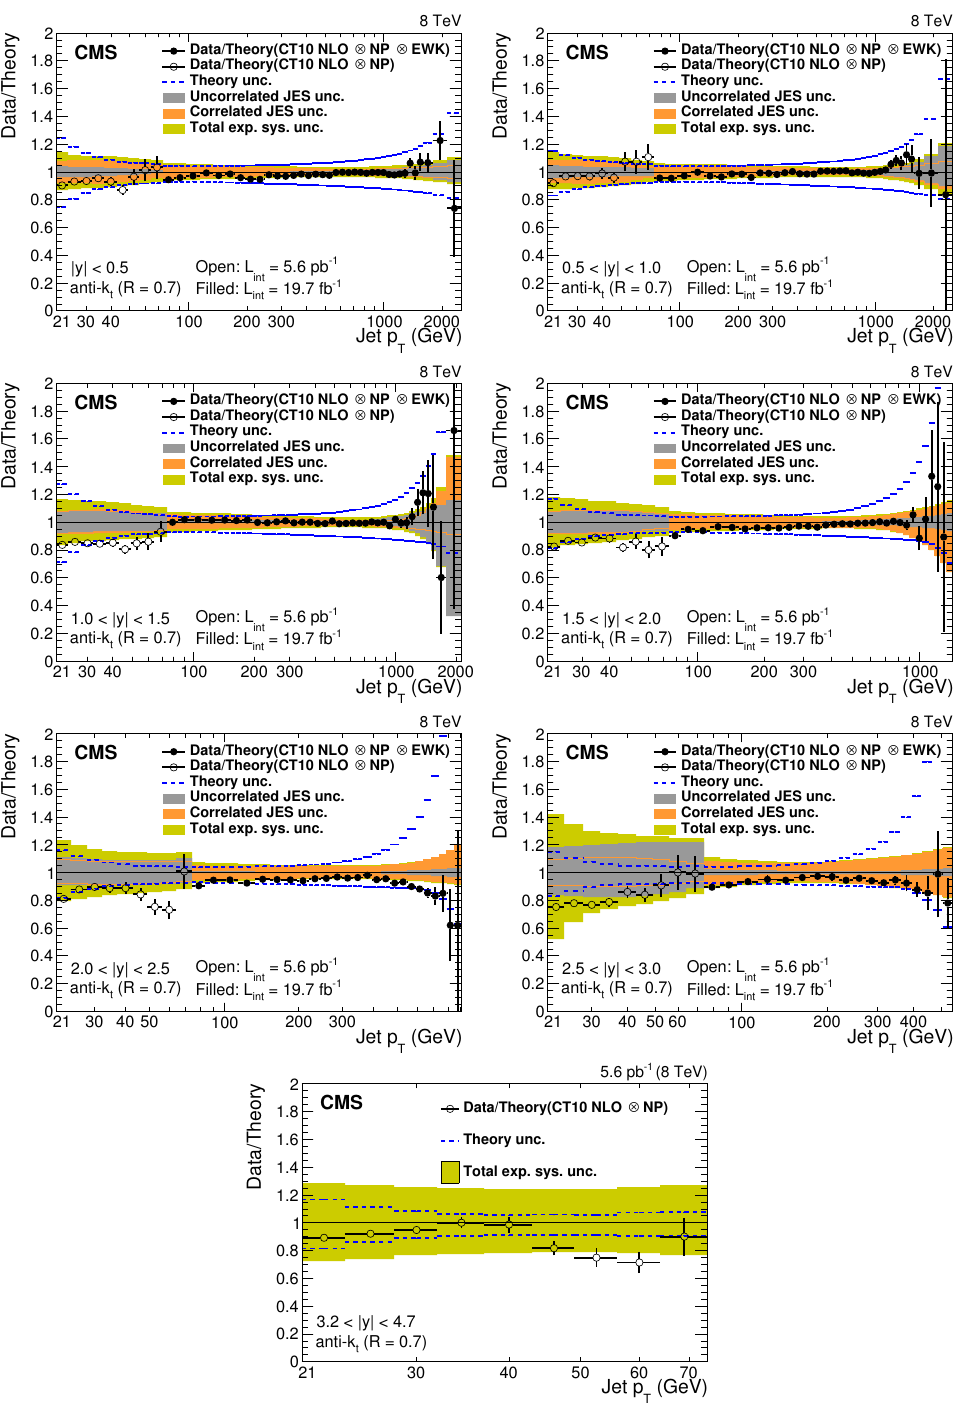
Figure 4 . Ratios of data to the theory prediction using the CT10 PDF set. For comparison, the total theoretical (band enclosed by dashed lines) and the total experimental systematic uncertain- ties (band enclosed by full lines) are shown as well. The error bars correspond to the statistical uncertainty in the